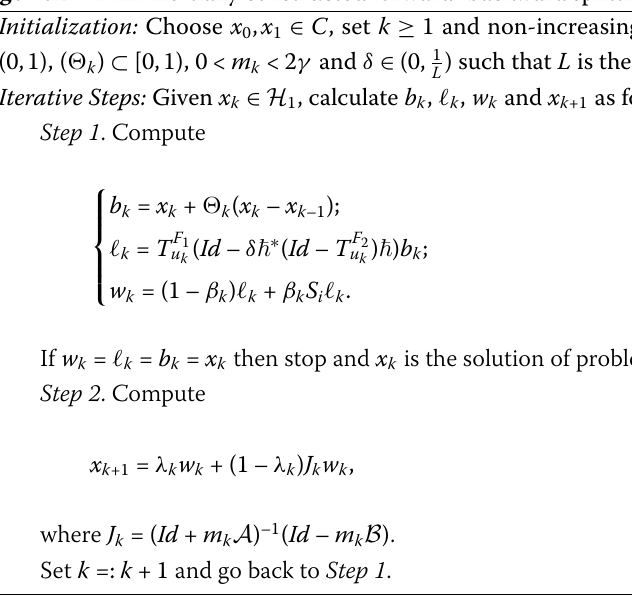
Algorithm 1 An inertially constructed forward–backward splitting